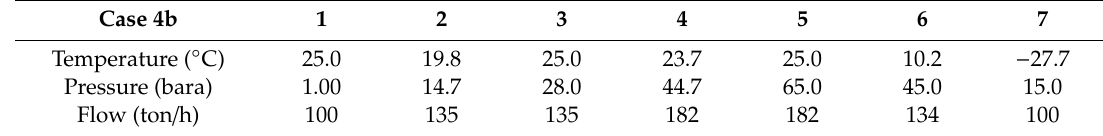
Table A9. Mass balance for Case 4b, stream numbering from Figure 1.